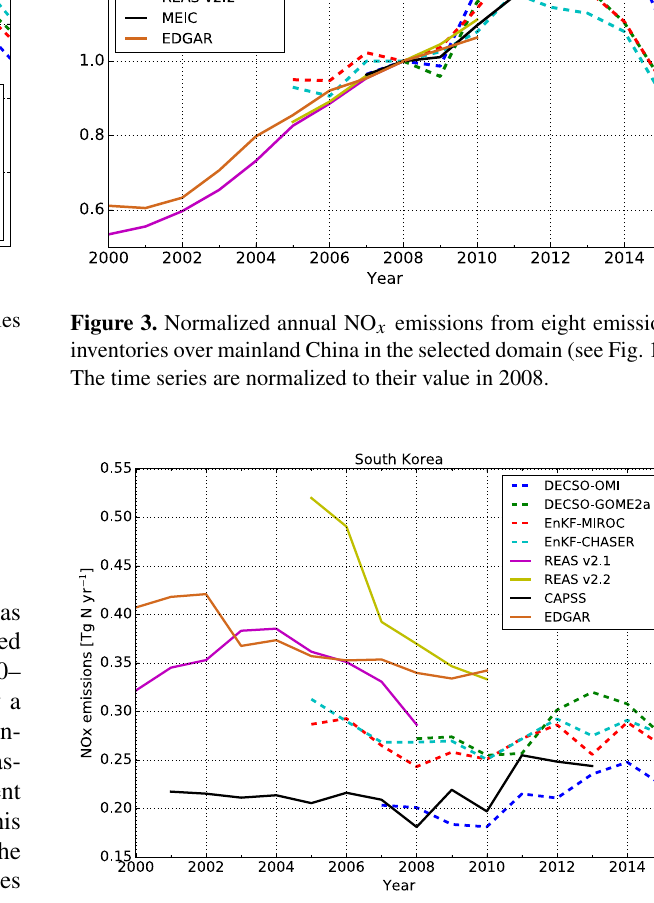
Figure 4. Annual NO x emissions from eight inventories over South